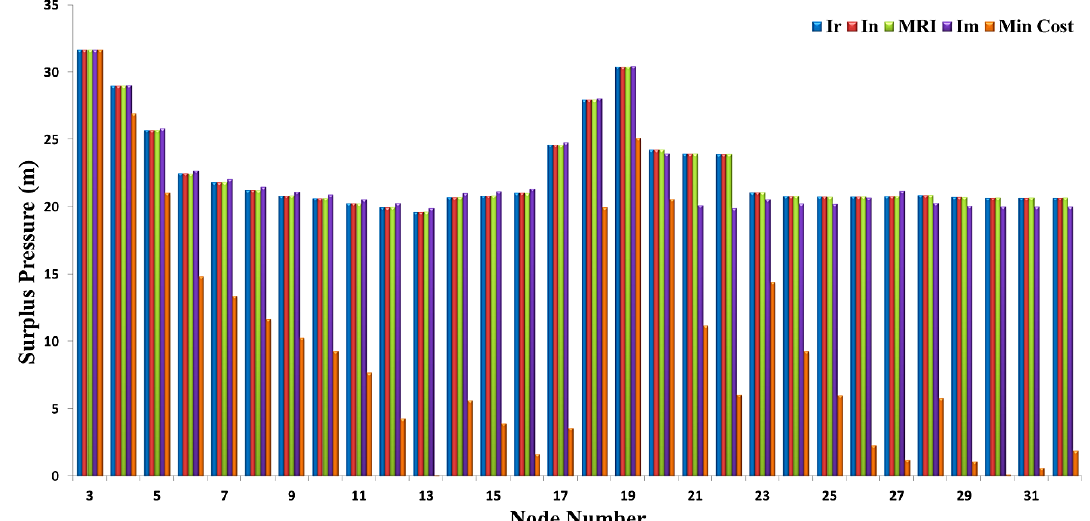
Figure 4. Nodal surplus pressure of Hanoi network for solutions of maximum reliability criteria and minimum cost.